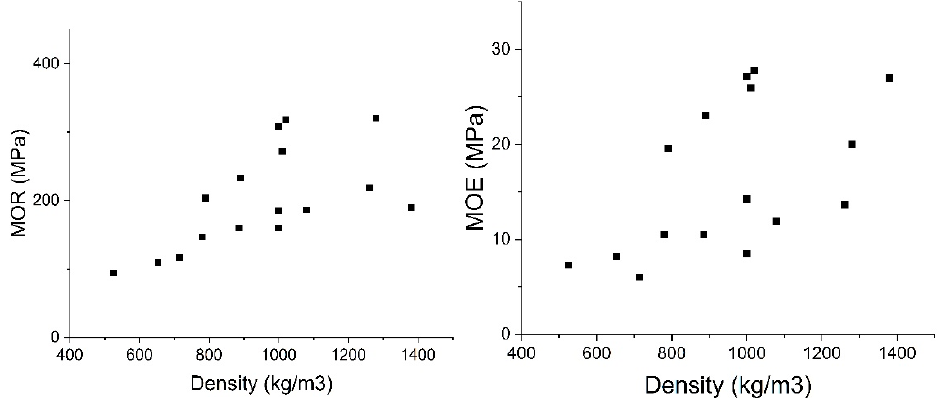
Figure 12. Bending-density results of data presented in Table 3.